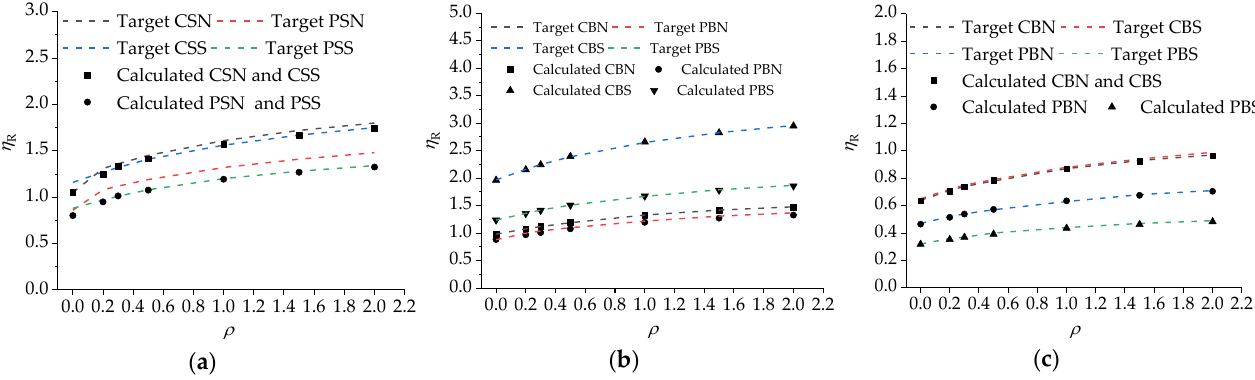
Figure 10. Fitting curves of modification factor of resistance for joints: ( a ) Joints with SPF panel; ( b ) Joints with BS panel under monotonic load; ( c ) Joints with BS panel under cyclic load.